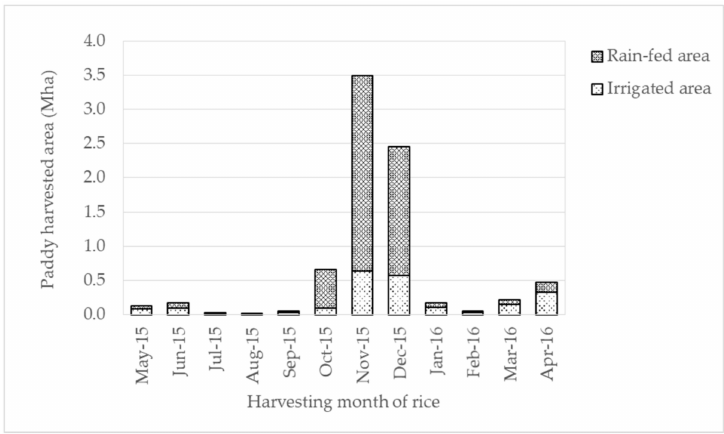
Figure 3. Monthly distribution of paddy harvested area in Thailand categorized by water resources during the crop season of